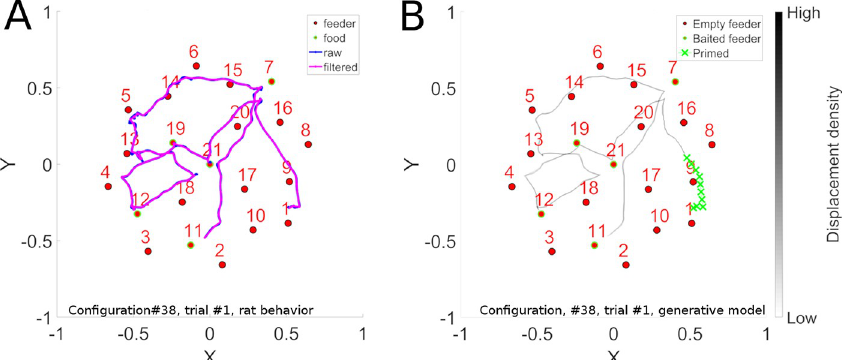
Fig 4. Sequence learning. Panel A illustrates a long convoluted trajectory taken by a rat in configuration 38. Panel B illustrates the probability maps of trajectories generated by the trained model in autonomous sequence generation mode. The 2D trajectory histogram is generated by superposing the trajectories generated when 10 batches of 100 reservoirs each were trained and each model instance was evaluated 10 times with noise. Note that there are two locations where the trajectory crosses itself. At the point of crossing, there are two possible paths that preserve path continuity. The system has memory of the context of how it got to that intersection point, and thus can continue on that trajectory. This illustrates that the model is well able to learn such complex